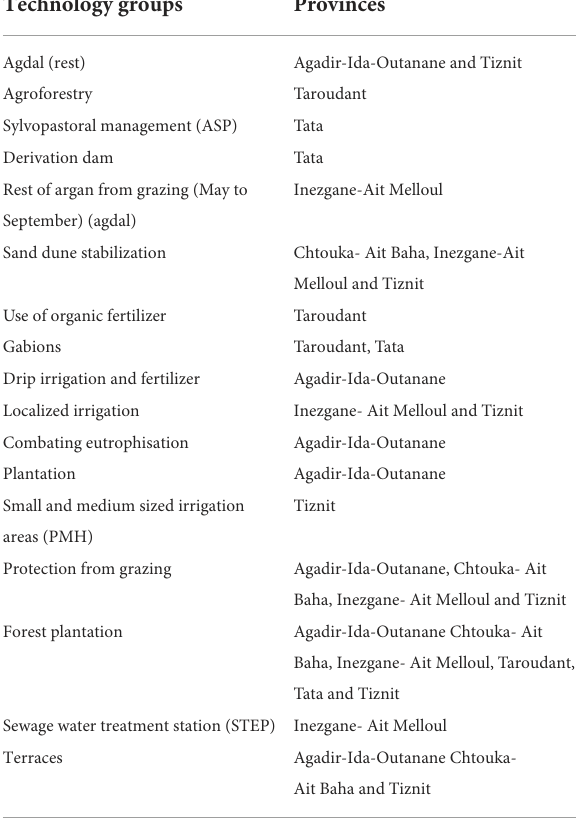
TABLE 2 SLM technologies and approaches in the Souss-Massa region and the affected provinces. Technology